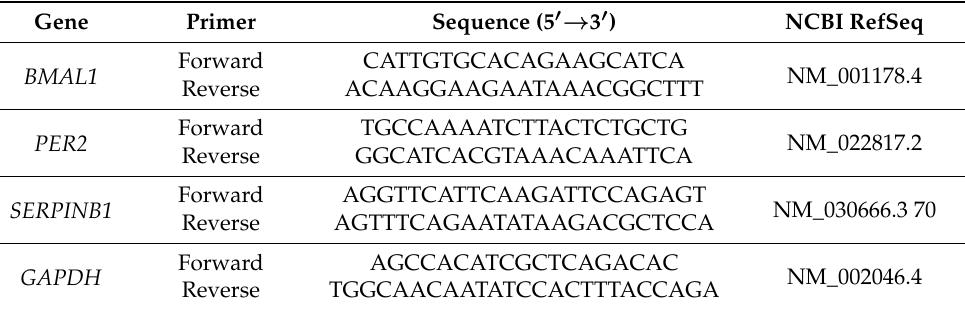
Table 2. List of primers for clock